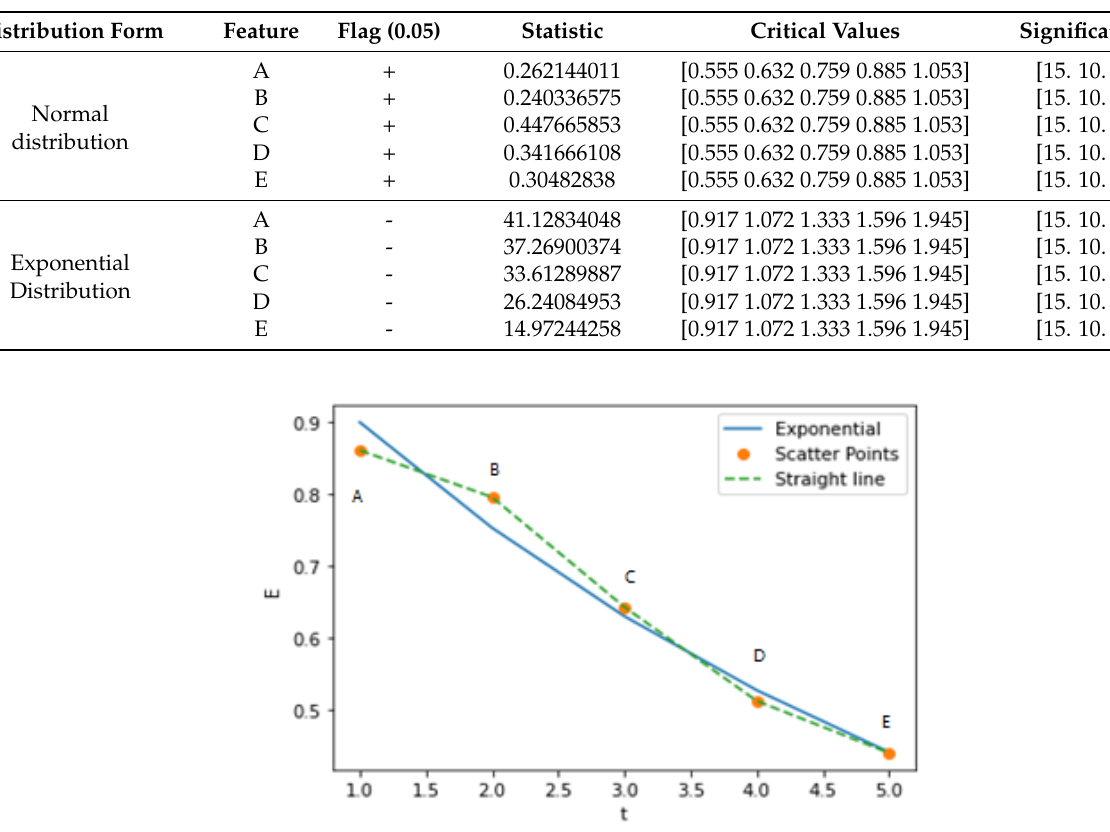
Table 10. Distribution pattern test results based on Anderson–Darling test.